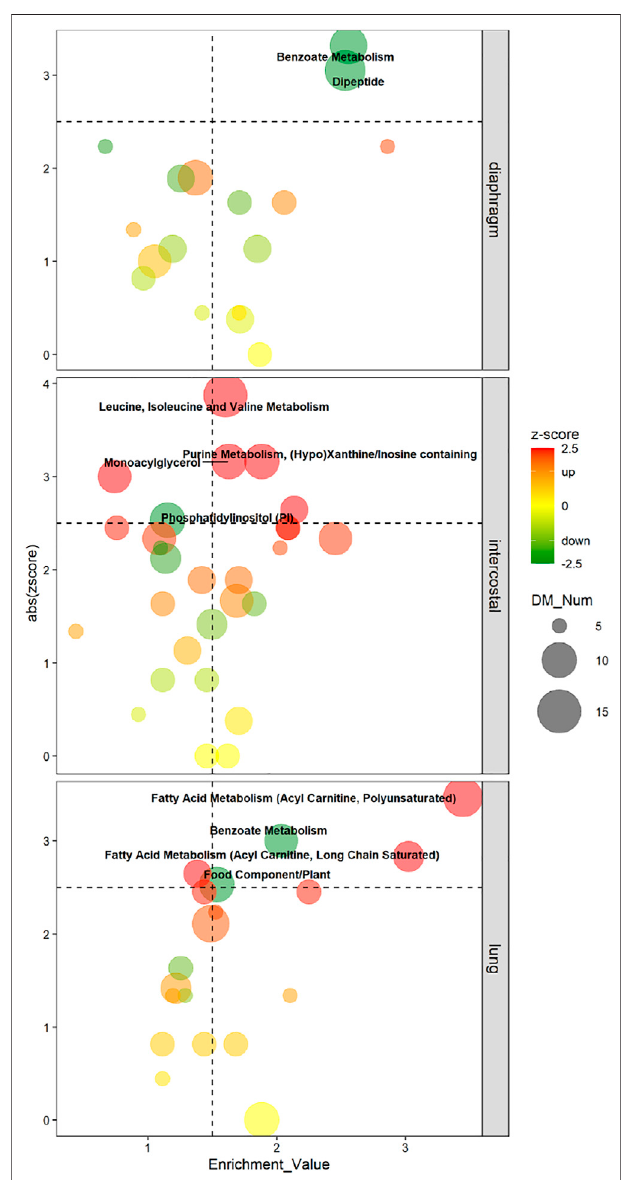
FIGURE 4 | Four-Quadrant charts demonstrate the metabolomic pathway signatures of each tissue in response to 5-day CMV. X-axis represents the enrichment value of the pathway; Y-axis represents the absolute zscore of the pathway. Metabolic subpathway signatures is considered when enrichmentvalue ≥ 1.5and abszscore ≥ 2.5.Color scalebar represents zscore which is used to predict the status of the pathway. Green color (negative zscore) indicates downregulation, whereas red color (positive zscore)indicatesupregulation.DotsizerepresentsthenumberofDMsineach